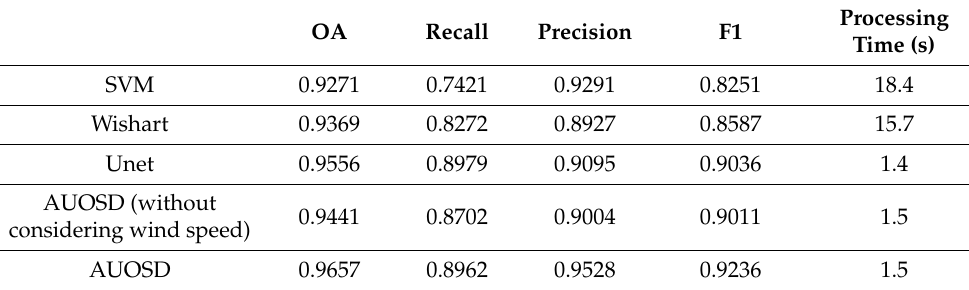
Figure 4. Oil-spill-detection results of the different methods: ( a ) the original Sentinel-1 PolSAR images; ( b ) the label images; ( c ) SVM; ( d ) Wishart; ( e ) U-Net model; ( f ) the AUOSD model without considering wind speed; ( g ) the proposed AUOSD model. Table 4. Quantitative-assessment results of the different oil-spill-detection